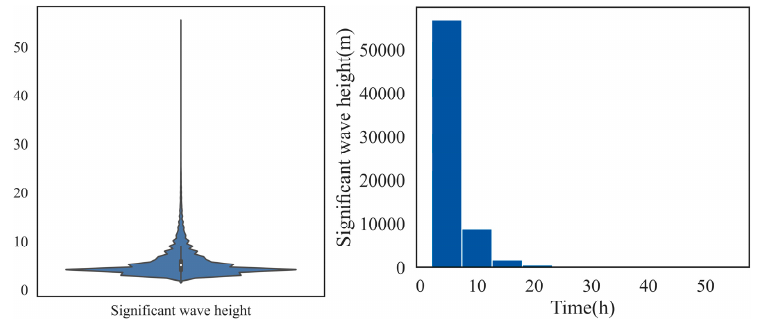
Figure 5. Violin plot and frequency distribution histogram of effective data. In Figure 5, the violin plot is a combination of a box plot and a kernel density plot, providing us with a way to identify outliers. The white dots on the violin plot represent the median, the thick black bars represent the interquartile range, and the narrow black bars represent the upper and lower adjacencies. Furthermore, the shape of the violin plot shows the overall distribution of the data, which is similar to the results of the frequency distribution histogram. The differences between the specific violin and box plots are shown in Figure 6. From Figure 6, the violin and box plots give similar information, with the box plot giving additional mean values and the violin plot giving additional information on the distribution of the data. Although normally for machine learning values above the upper and lower adjacency can be considered as outliers and discarded. However, due to the non-linear and non-stationary nature of the SWH data, the volatility is much more dramatic than in normal statistics. The upper bound amplitude is much higher than the upper adjacency of the common statistical range and is real. It is very unjustified to simply discard some data in a crude manner. Therefore, a novel filter formulation for SWH outliers is proposed in this paper by manually checking the measured data from ShiDao monitoring station to remove the missing and extreme outlier values. The box plot of SWH effective data over the years is shown in Figure